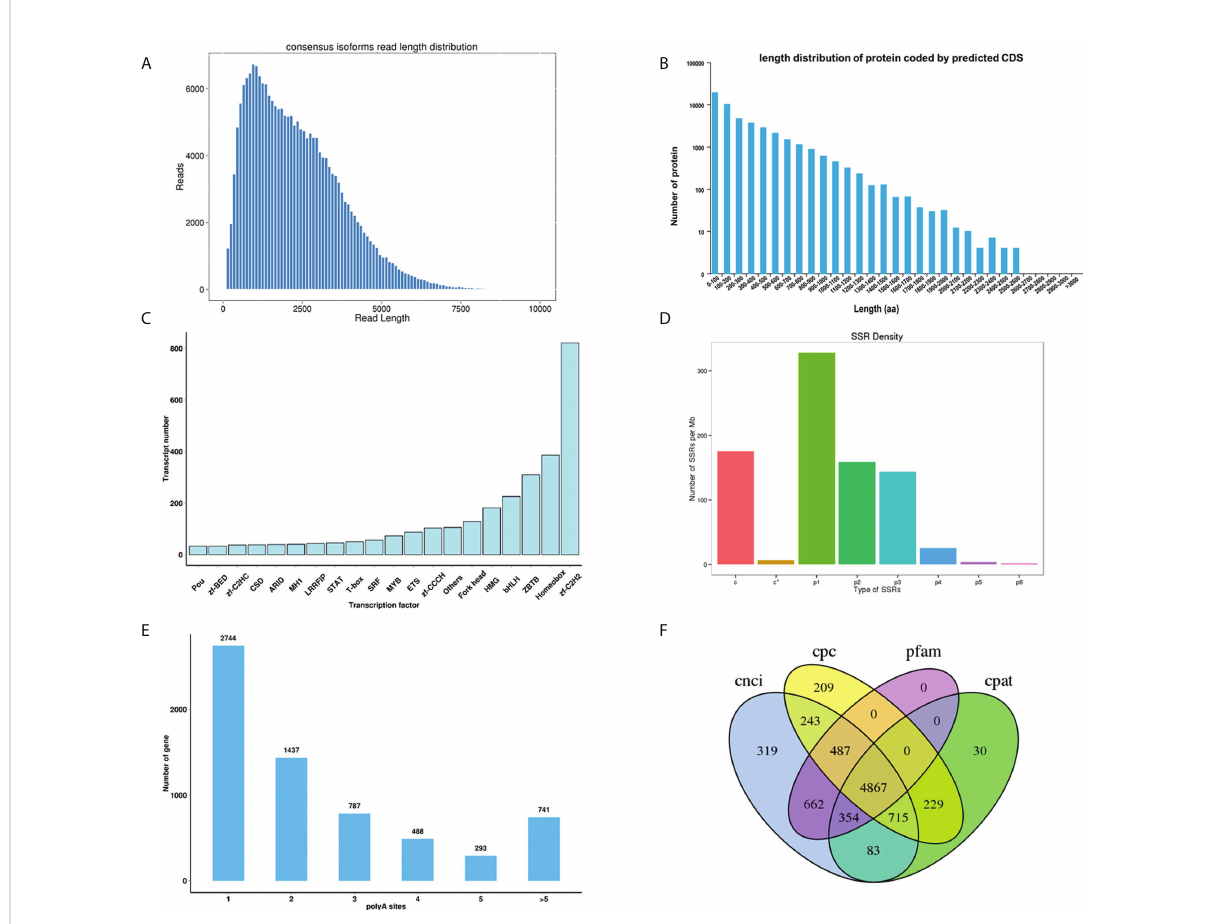
FIGURE 2 (A) Consensus isoforms read length distribution of Thamnaconus modestus ; (B) The coding protein length distribution of the predicted CDS; (C) Transcriptional factor prediction; (D) Distribution of different types of SSRs. (E) APA polyA sites distribution; (F) Venn diagram of the number of lncRNAs identi fi ed by CNCI, CPC, Pfam and